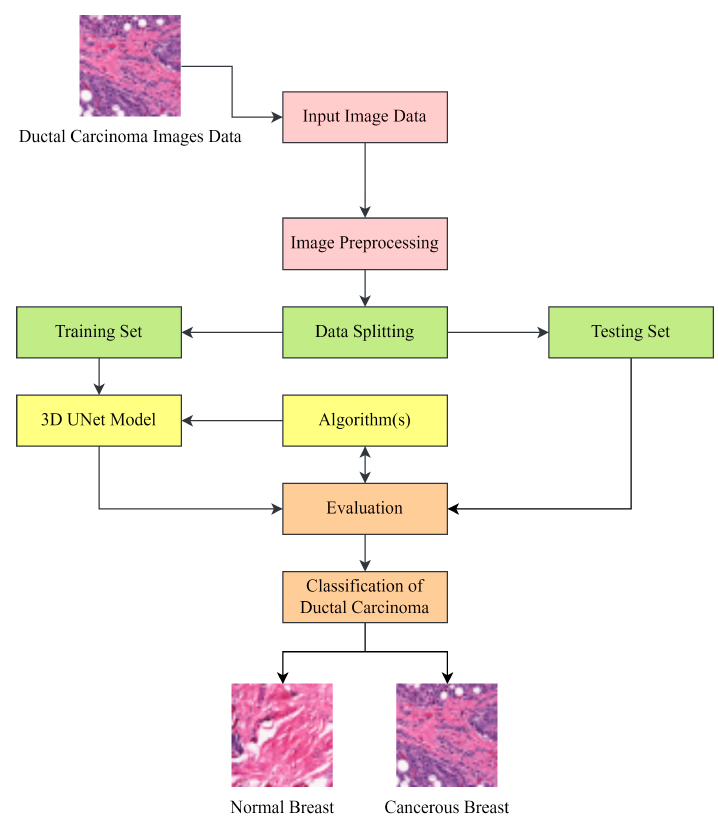
Figure 1. Flowchart of the proposed workflow adopted for ductal carcinoma